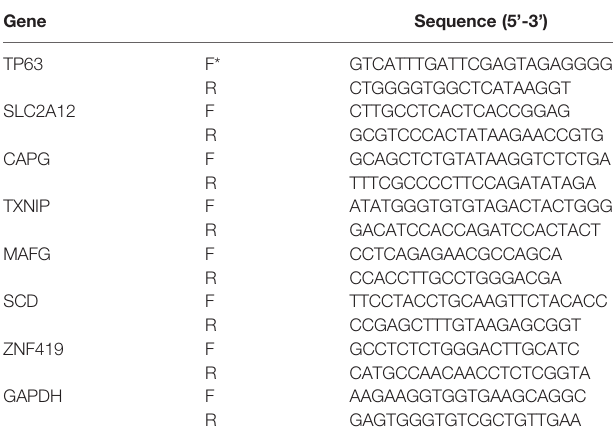
TABLE 1 | Primer sequences of related genes for